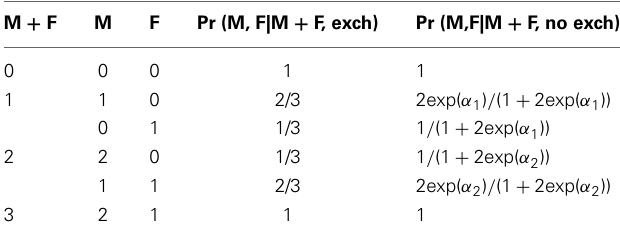
Table 1 | Probabilities of mating pairs conditional on mating sum when parental allelic exchangeability is present (exch), and when it is not (no